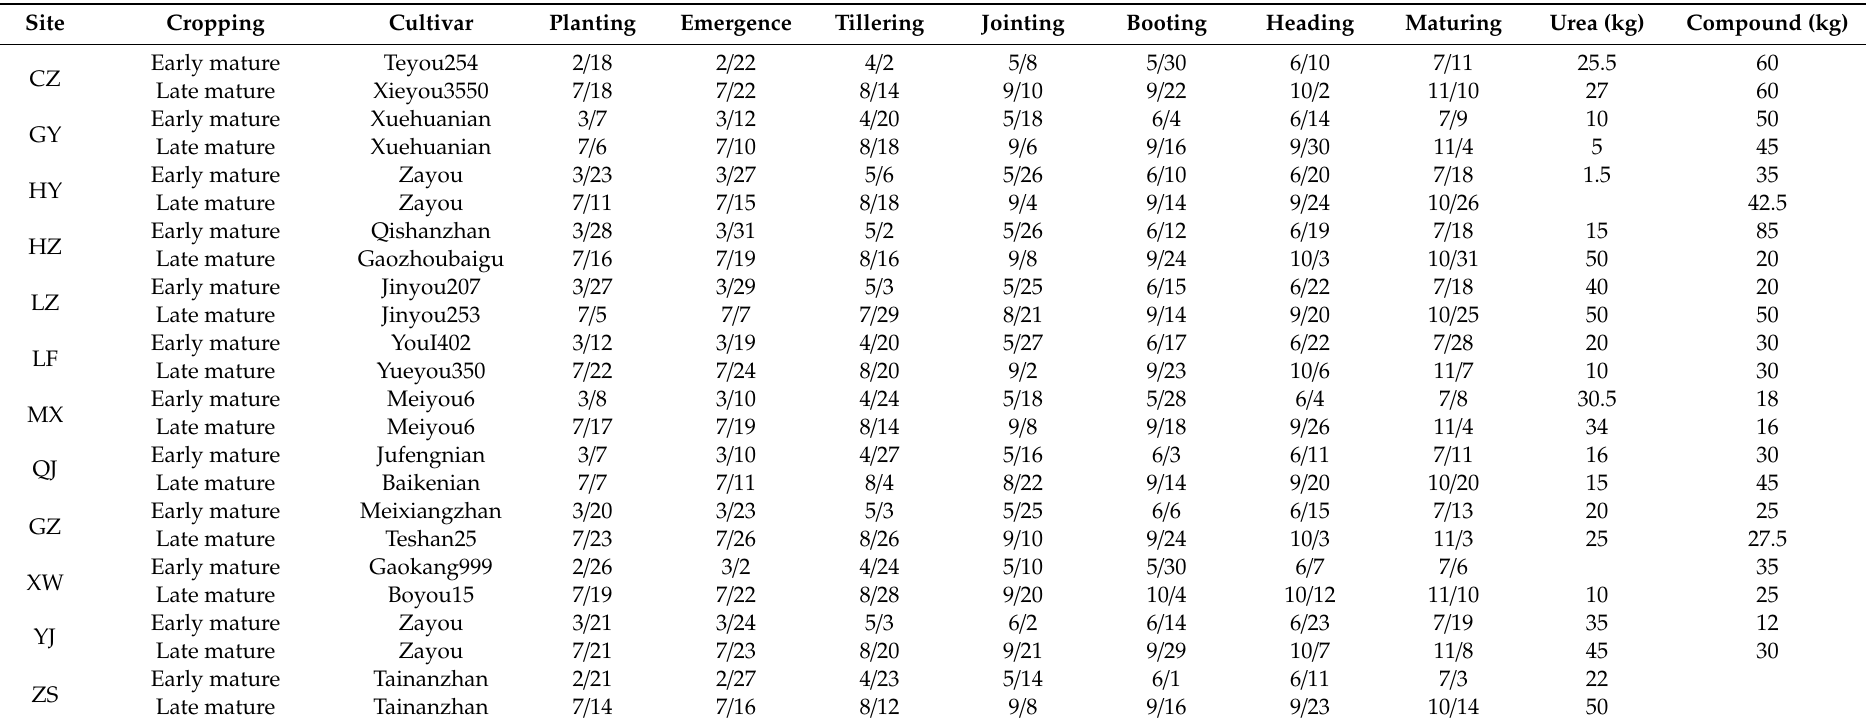
Table A2. Detailed information of the management of each